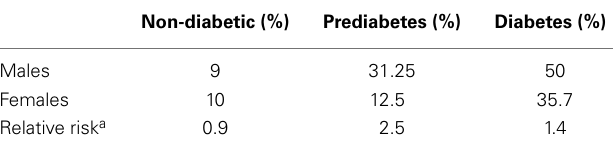
Table 3 | Frequency of microalbuminuria in a rural cohort of African-American males and females